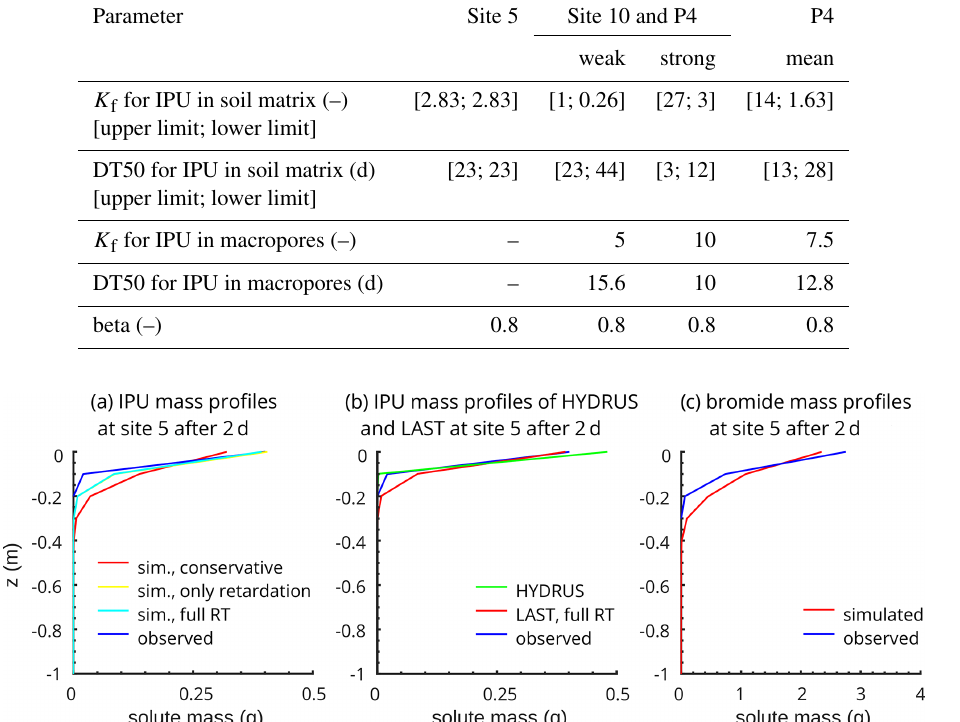
Table 2. Reactive transport parameters of IPU at sites 5, 10, and P4. The upper and lower value limits in the square brackets describe the value ranges of the depth-dependent K f and DT50 parameters between the soil surface and the starting depth of the subsoil (cf. Fig. 3, Sect. 3.1.2, 3.2.2). At sites 10 and P4, we distinguish between two parameter configurations for a rather weak reactive transport of IPU and a strong reactive transport with enhanced retardation and degradation of IPU. Exclusively at site P4, we additionally apply a mean reactive transport parameter configuration for the 7 and 21d simulations.